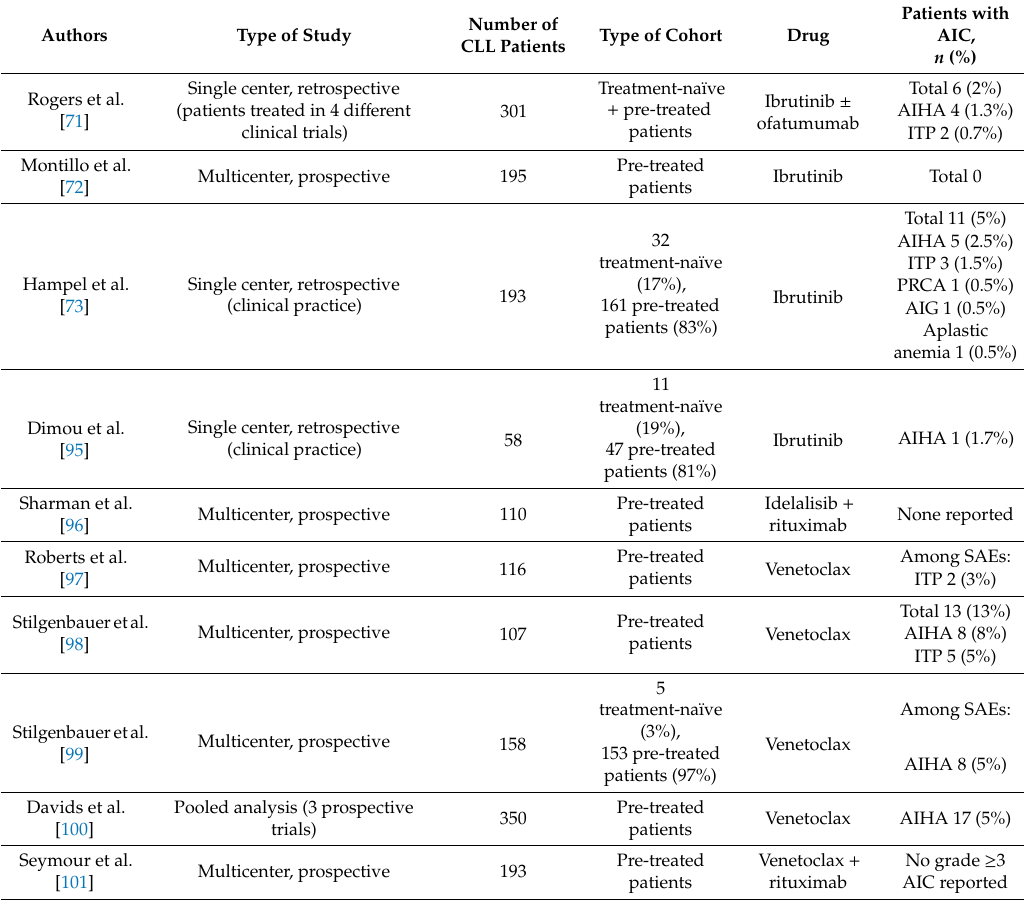
Table 3. Autoimmune cytopenias in patients with CLL treated with targeted agents.